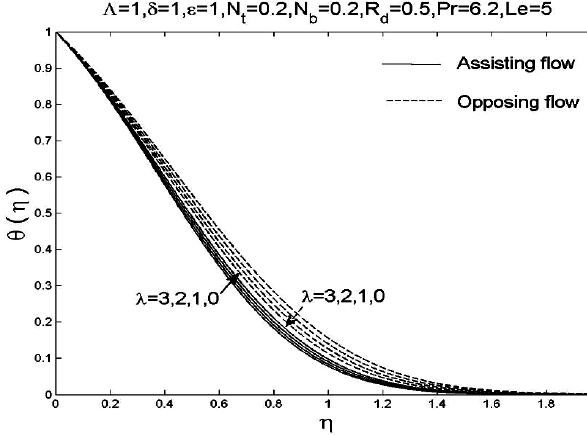
Fig. 12. The effect of the buoyancy parameter λ on the tempera- ture profiles ( ) θη .